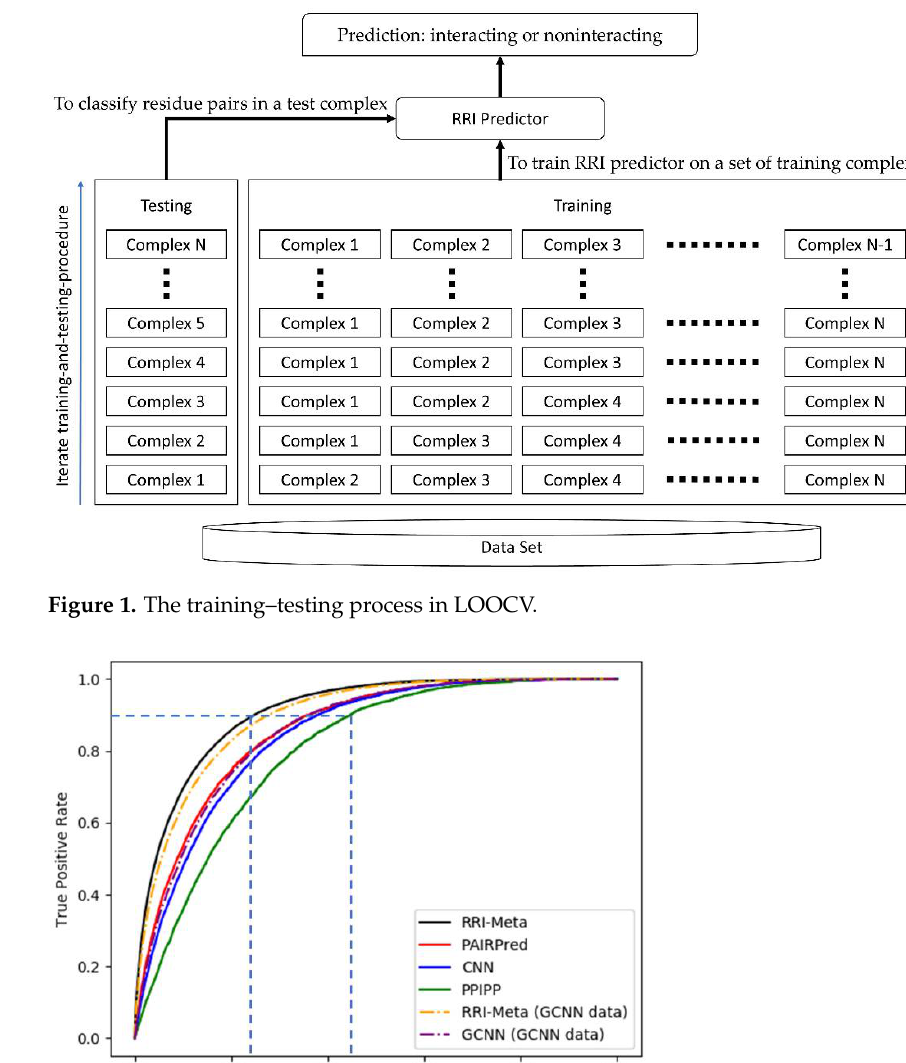
Figure 1. The training–testing process in LOOCV. Table 1. Average results for LOOCV on DBD 5.0.